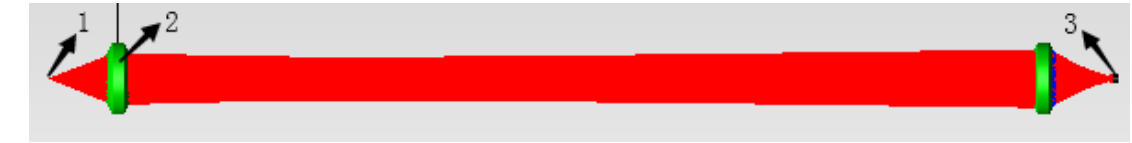
Figure 2. Optical simulation of the two convex lenses, where 1 is the output beam from the paraboloid concentrator, 2 is the convex lens and 3 is the detector.